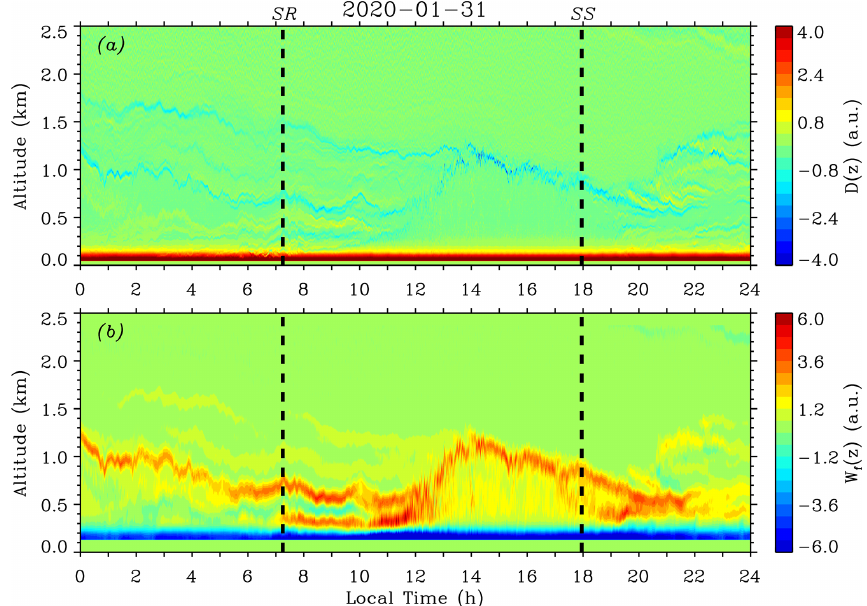
Figure 2. Contour plots of (a) D(z) and (b) W f (z) on 31 January 2020. Sunrise (SR) and sunset (SS) times are marked by thick black dashed lines. Multiple (residual) aerosol layers that definitely lead to misattribution of ABL depth are clearly indicated by stripes of local minima of D(z) and maxima of W f (z) in the contour plots. By visualizing these contour plots, proper upper heights for applying the variance method can be conveniently and correctly determined to be below the base of multiple (residual) aerosol layers aloft.